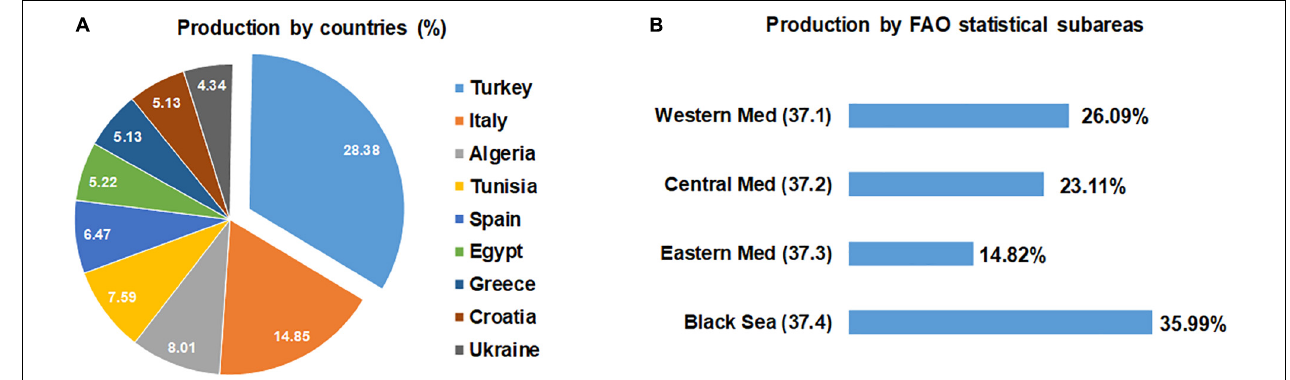
FIGURE 1 | (A) Top ranked fishing nations in the Mediterranean and Black Seas and (B) portion of catches taken from each subregion in 2017 (Food and Agriculture Organization [FAO], 2018).